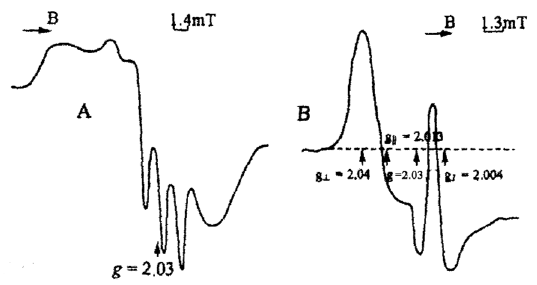
Figure 2. The EPR spectra recorded in lyophilized preparations of the blood ( A ) and liver mitochon- dria of rats treated intravenously with sodium nitrite at 77 K ( B ) [50].